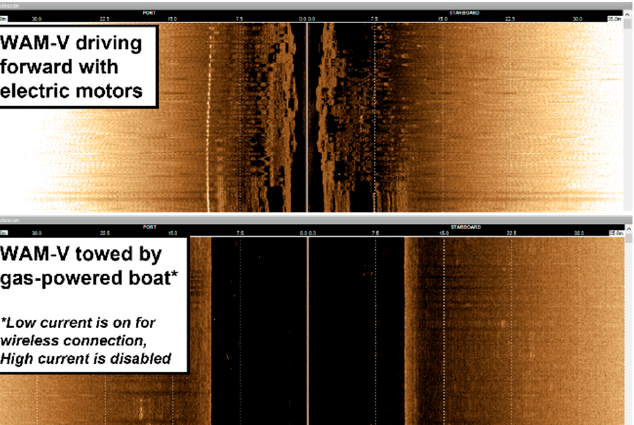
Figure 2. Comparison of the observed return of the side-scan sonar system aboard a USV operating under its own propulsion system and with the same USV being towed 25 ft behind a gasoline-powered research vessel.